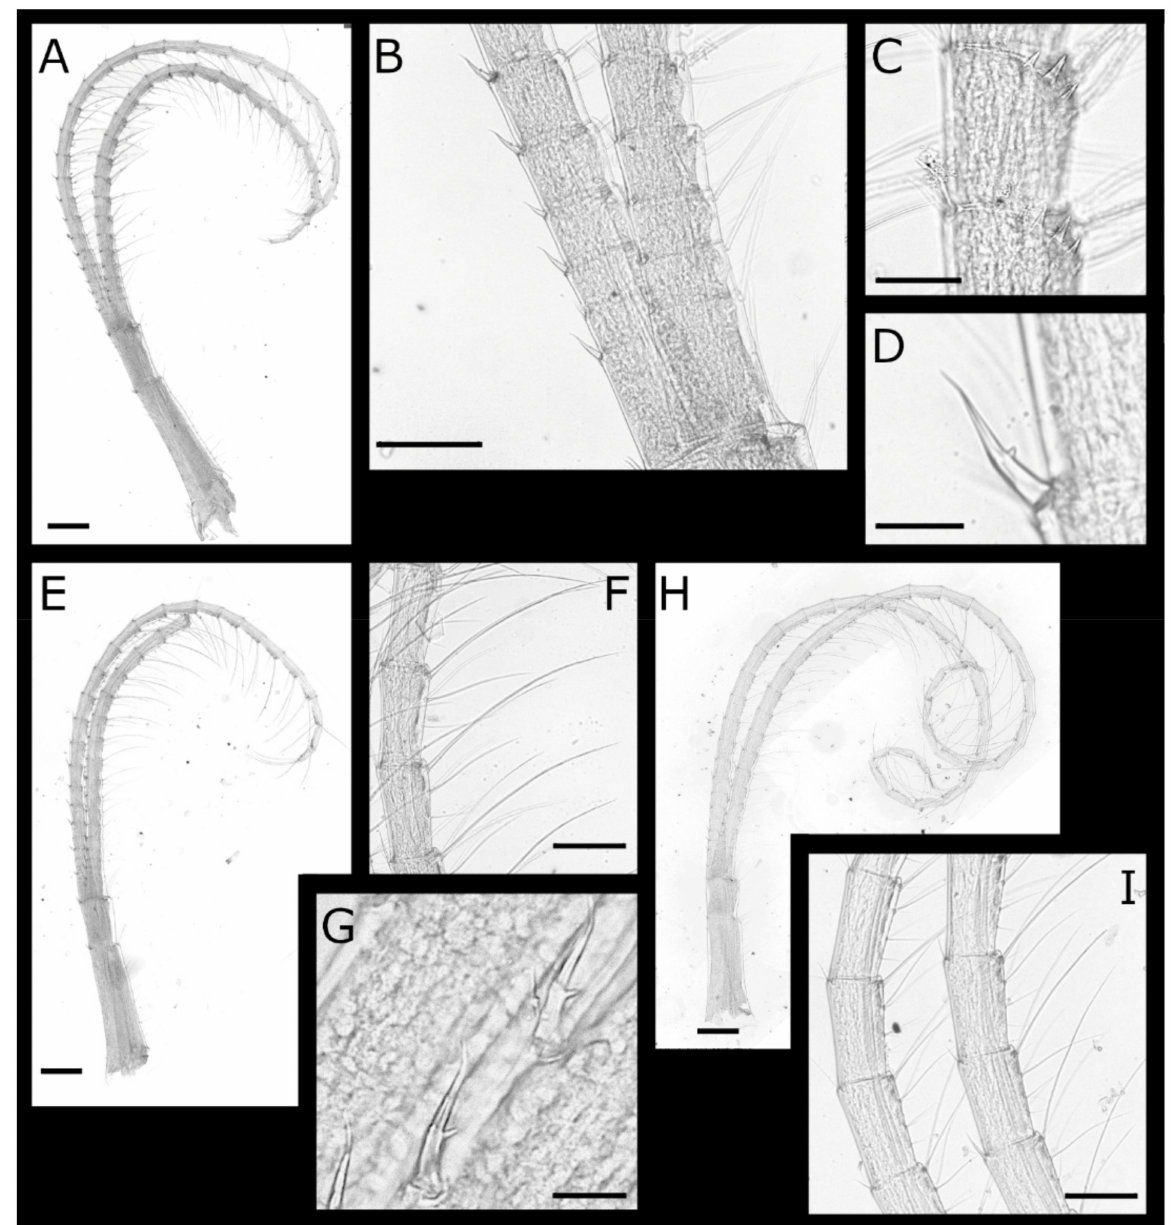
Figure 8. Acasta fenestrata Darwin, 1854 cirri IV–VI (all WAM C58749). ( A ) left cirrus IV; ( B ) basal segments of left cirrus IV; ( C ) erect spines on medial segments of cirrus IV anterior ramus; ( D ) multicuspidate seta on posterodistal angle of cirrus IV posterior ramus; ( E ) left cirrus V; ( F ) setation on medial segments of cirrus V anterior ramus; ( G ) multicuspidate setae on basal segments of cirrus V anterior ramus; ( H ) left cirrus VI; ( I ) setation on intermediate segments of cirrus VI posterior and anterior rami. Scale Bars: A, E, H = 200 µ m; B =100 µ m; C, F, I = 50 µ m; D, G 20 µ